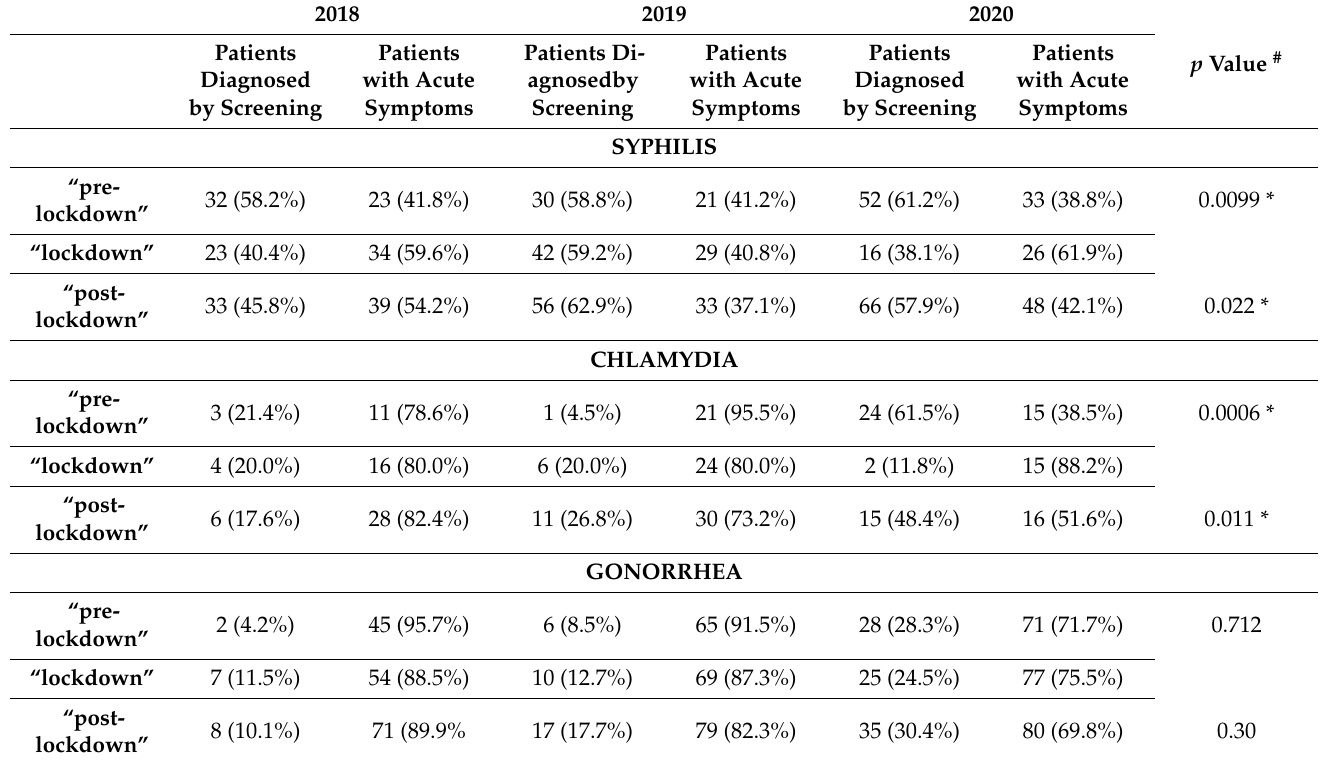
Table A2. The number and proportion (%) of patients diagnosed through screening and with